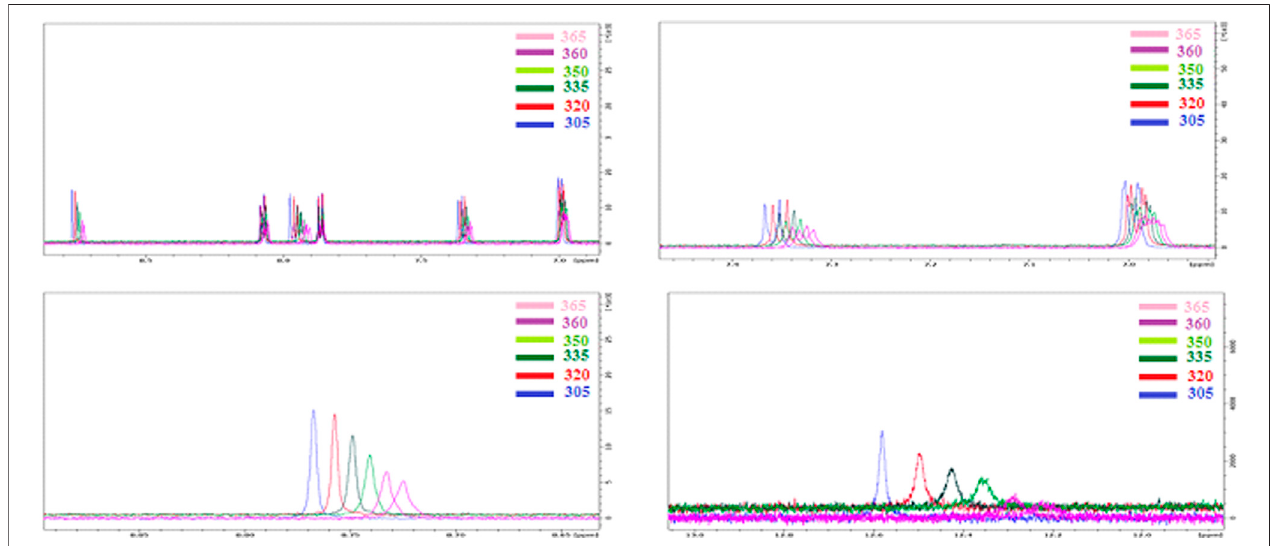
FIGURE 3 | NMR 1:1 supramolecular H -bonded complexes (I/A8) with temperature gradient, T (cid:2) 305 – 365